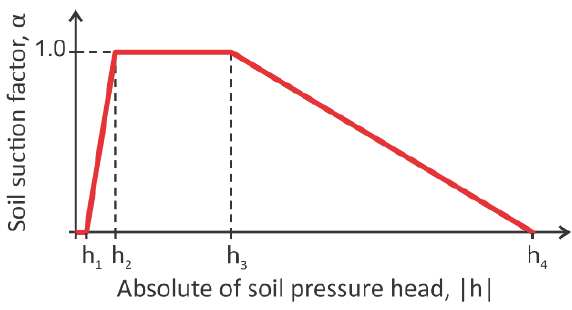
Figure 4. The general form of soil suction factor (adapted from [70]).